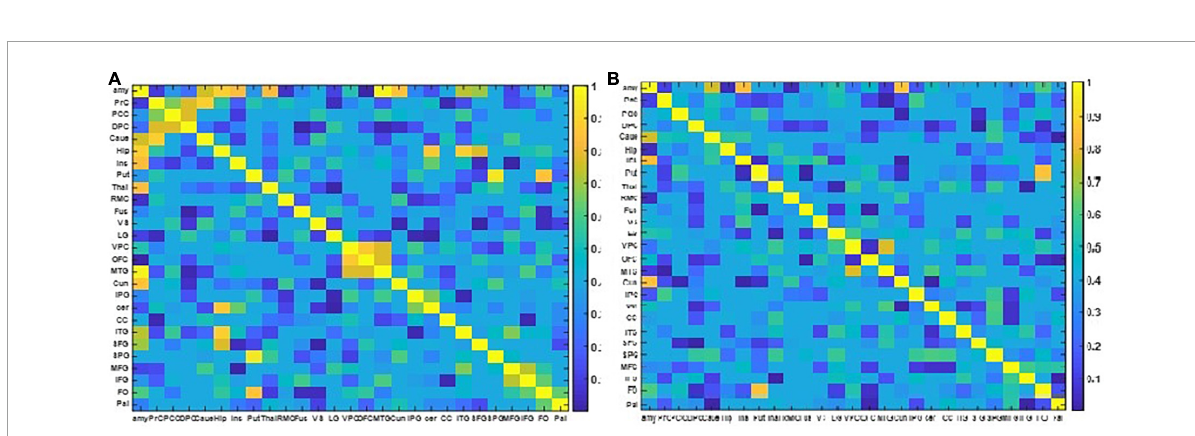
FIGURE6 The two NMI matrixes computed from the EEG and fMRI dFC from resting state to view and upregulation states. (A) In the frequency range of 1–15 Hz, (B) in the frequency range of 15–40 Hz.